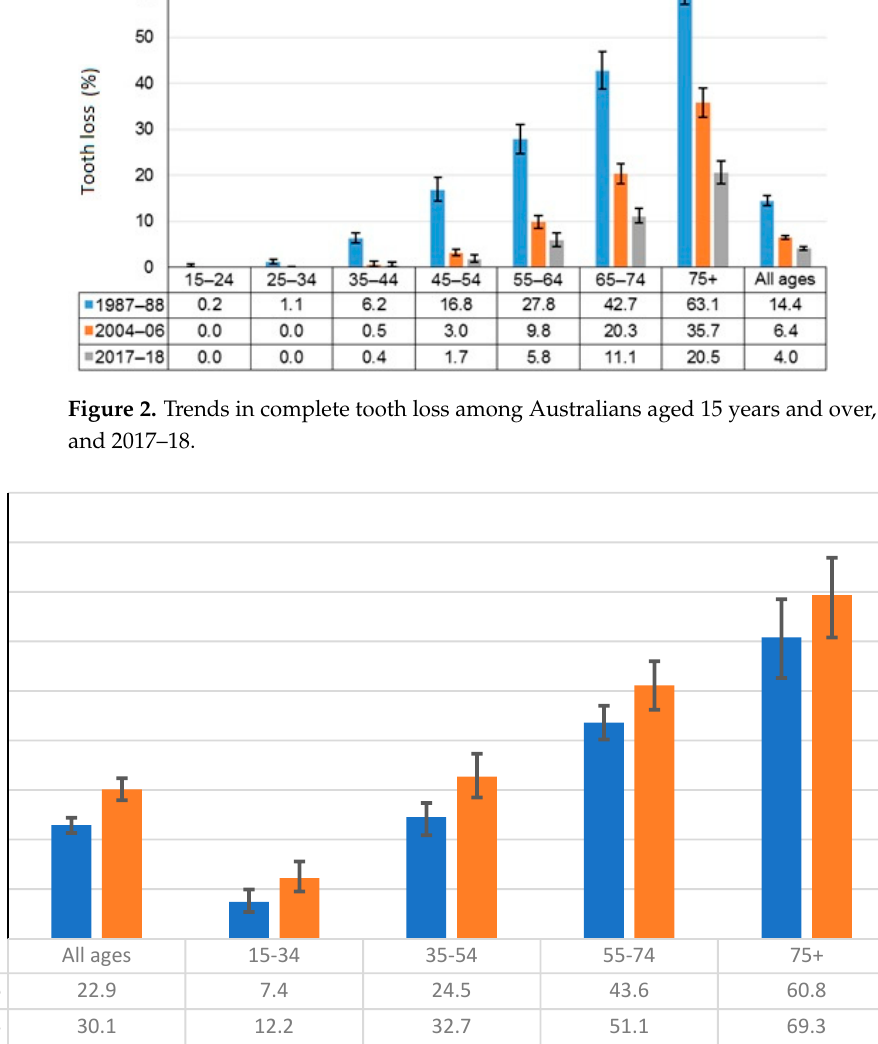
Figure 3. Comparison of the prevalence of moderate or severe periodontitis among dentate Australians aged 15 years and over between 2004–06 and 2017–18.